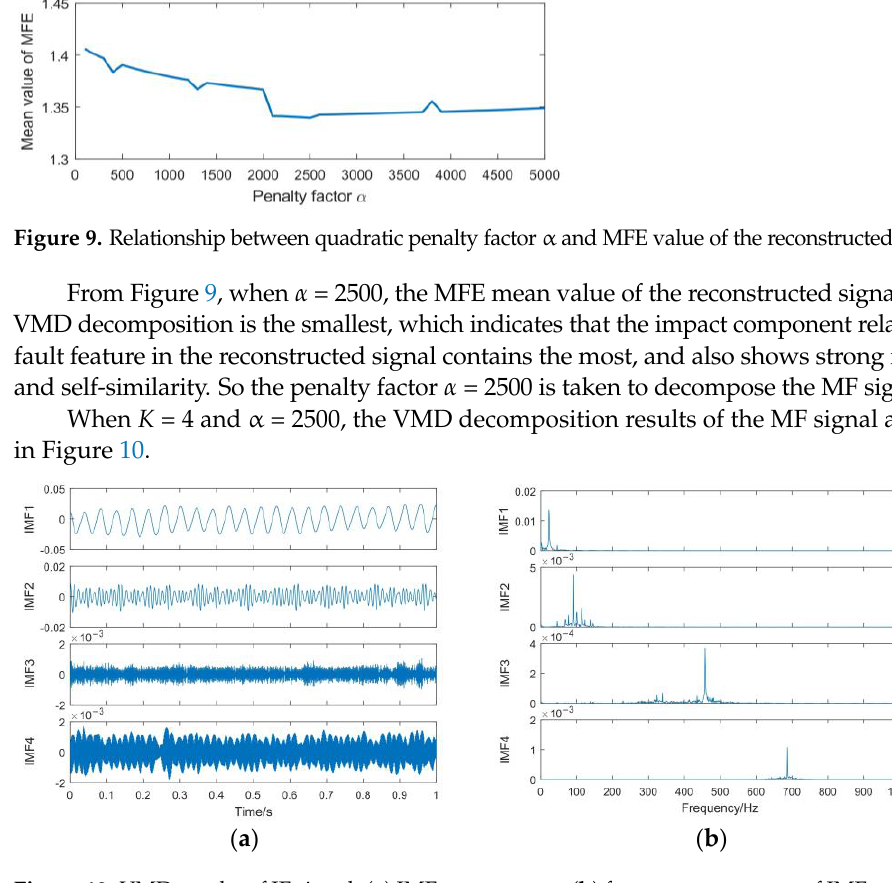
Figure 11. CEF value of each IMF component.